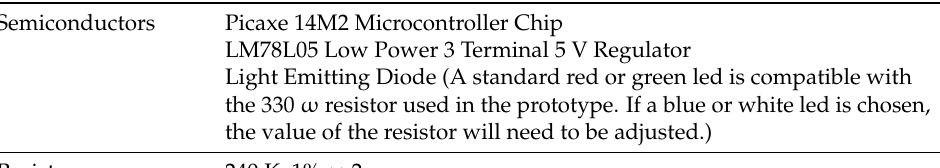
Figure 3. Voltage divider circuit operation. The outputs of the CD4066 chip are fed to a voltage divider consisting of a 240 K fixed resistor, a 50 K 25-turn trim potentiometer and a fixed 1 K resistor. A total resistance of 250 K will result in a current of I = 5/250,000 = 20 µA flowing through the voltage divider. This will result in a fixed potential of V d = 20 × 1000 = 20 mV. The WPI Intra 767 will produce current pulses of 1 nA for a 20 mV input. Table 1. Bill of components.